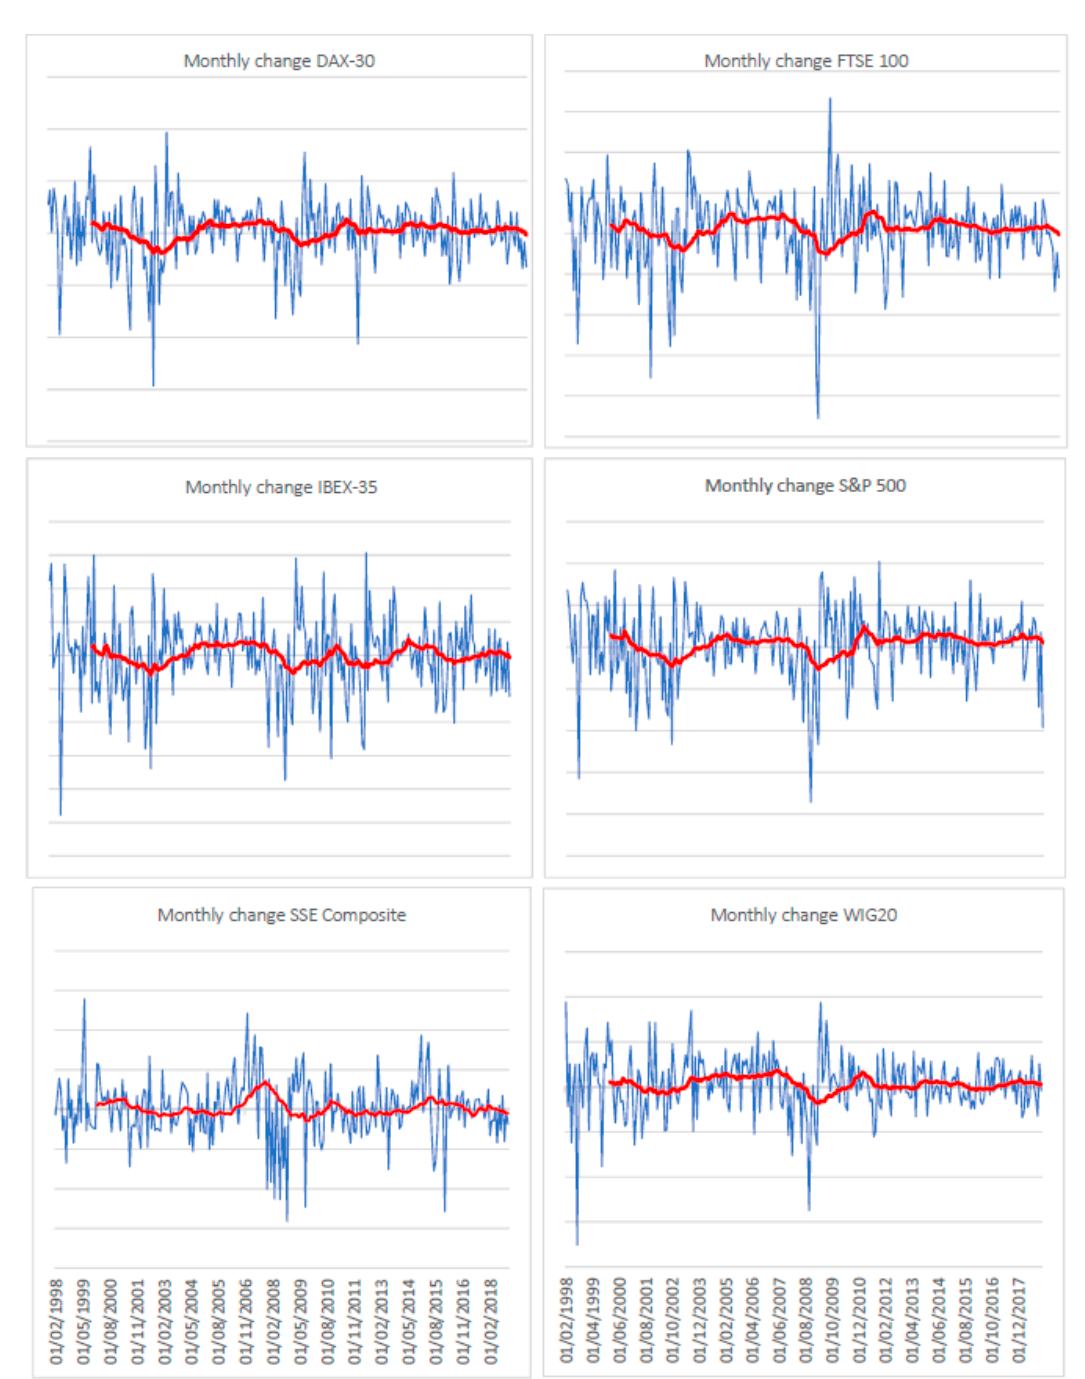
Figure 1. Monthly changes in closing price (monthly log ‐ returns) of each international stock market from January 1998 to December 2018. (Own study based on results obtained via Excel Calculation Sheet). Table 2. Correlation level between log ‐ returns of international stock markets.